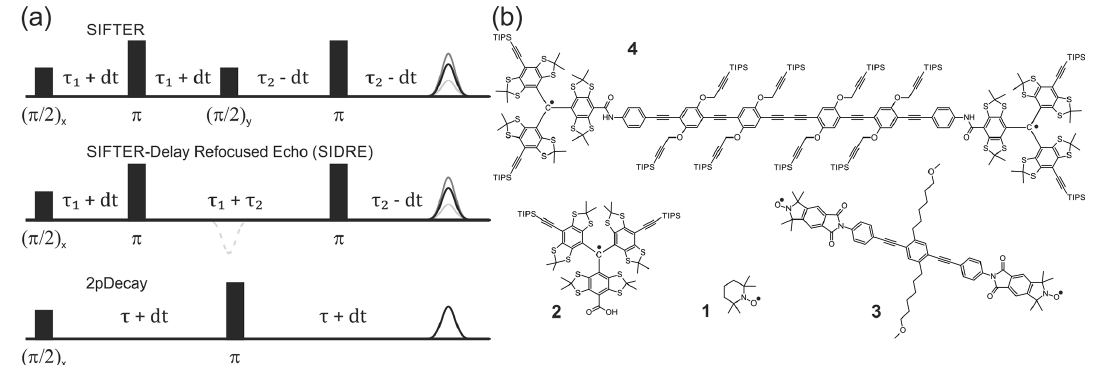
Figure 1. Pulse sequences used in experiments are shown in (a) . The time axis in SIFTER traces is t = τ 1 − τ 2 , and the interpulse delays are incremented/decremented by d t to keep the total transverse evolution time 2 τ 0 = 2( τ 1 + τ 2 ) constant. The chemical structures of the studied compounds are depicted in (b) . Nitroxide monoradical (TEMPO) (1), trityl monoradical (2), nitroxide biradical (3) and trityl biradical (4). TIPS is